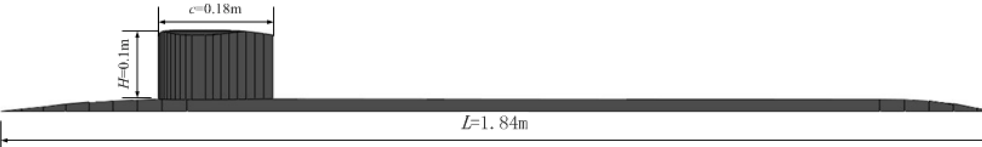
Figure 2. The diagram of the model. The model is a whole sail hull with part of the body. The dimension is scaled from the SUBOFF model. The length ( L ) of the sail hull is 184 cm. The height ( H ) of the sail hull is 10 cm. The chord length (c) is 18.4 cm.